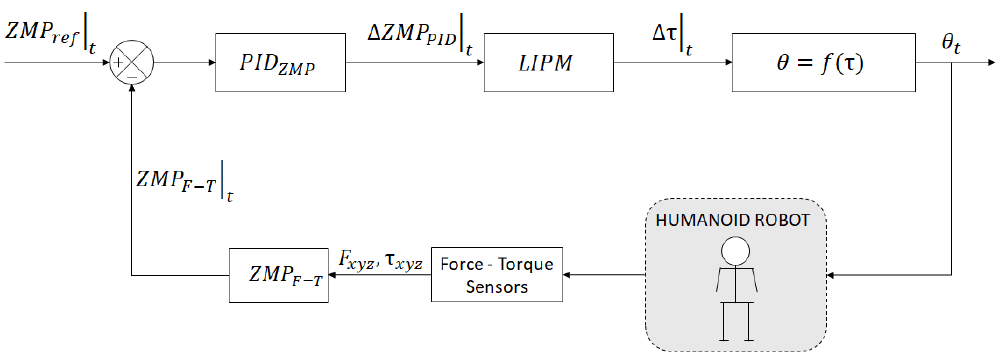
Figure 9. Basic ZMP position controller using the LIPM